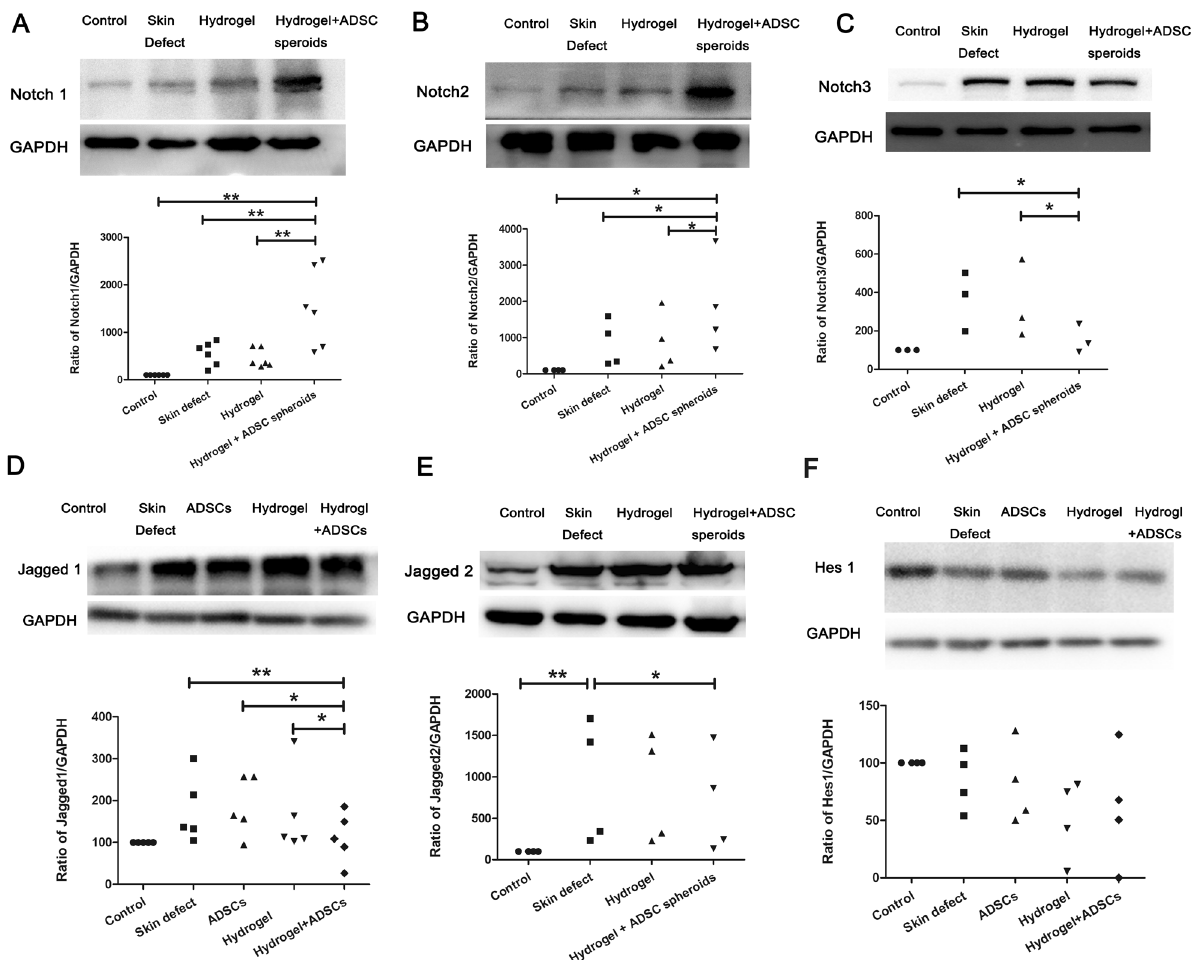
Fig. 6 The DA-MeHA hydrogel regulated Notch signaling. A – E DA-MeHA hydrogel-encapsulated spheroids or suspensions of ADSCs upregulated the expression of Notch1 and Notch2 while downregulating the expression of Notch3, Jagged1 and Jagged2. F No signi fi cant difference in Hes1 expression was observed among the groups. n = 4 samples/group (* p < 0.05 and ** p < 0.01).